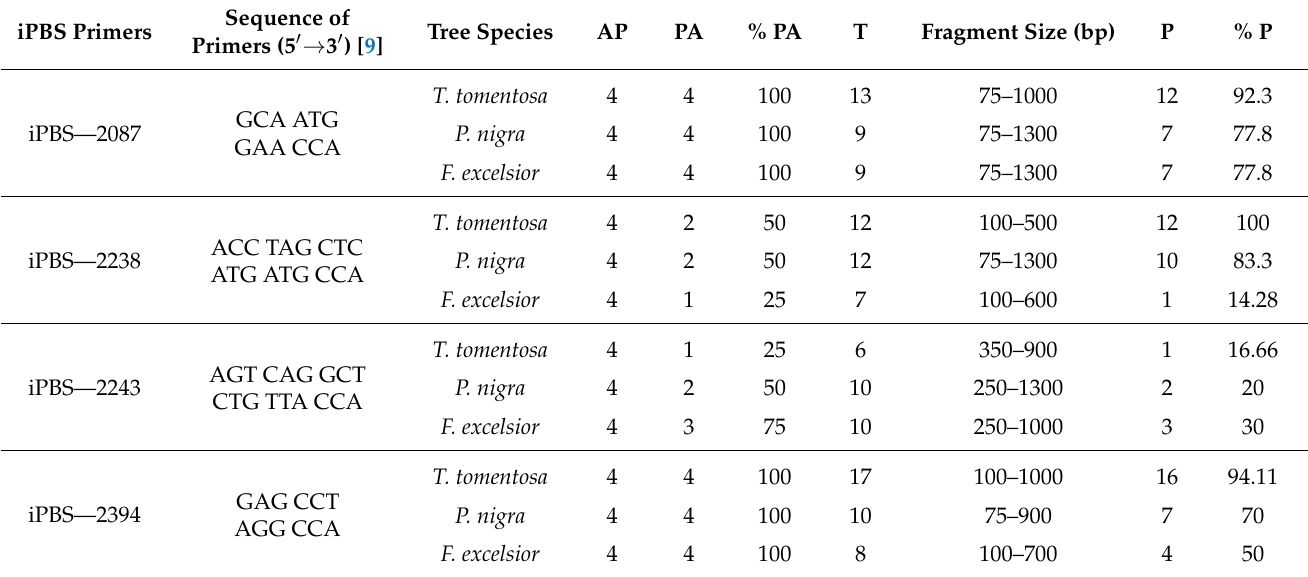
Table 6. Primer sequences and band scores for polymorphic iPBS reactions in tree species genotypes (AP = number of analyzed genotypes, PA = polymorphic genotypes, % PA = percentage of poly- morphic genotypes, T = total number of bands, P = polymorphic bands, and % P = percentage of polymorphic bands obtained with PCR amplification of tree species